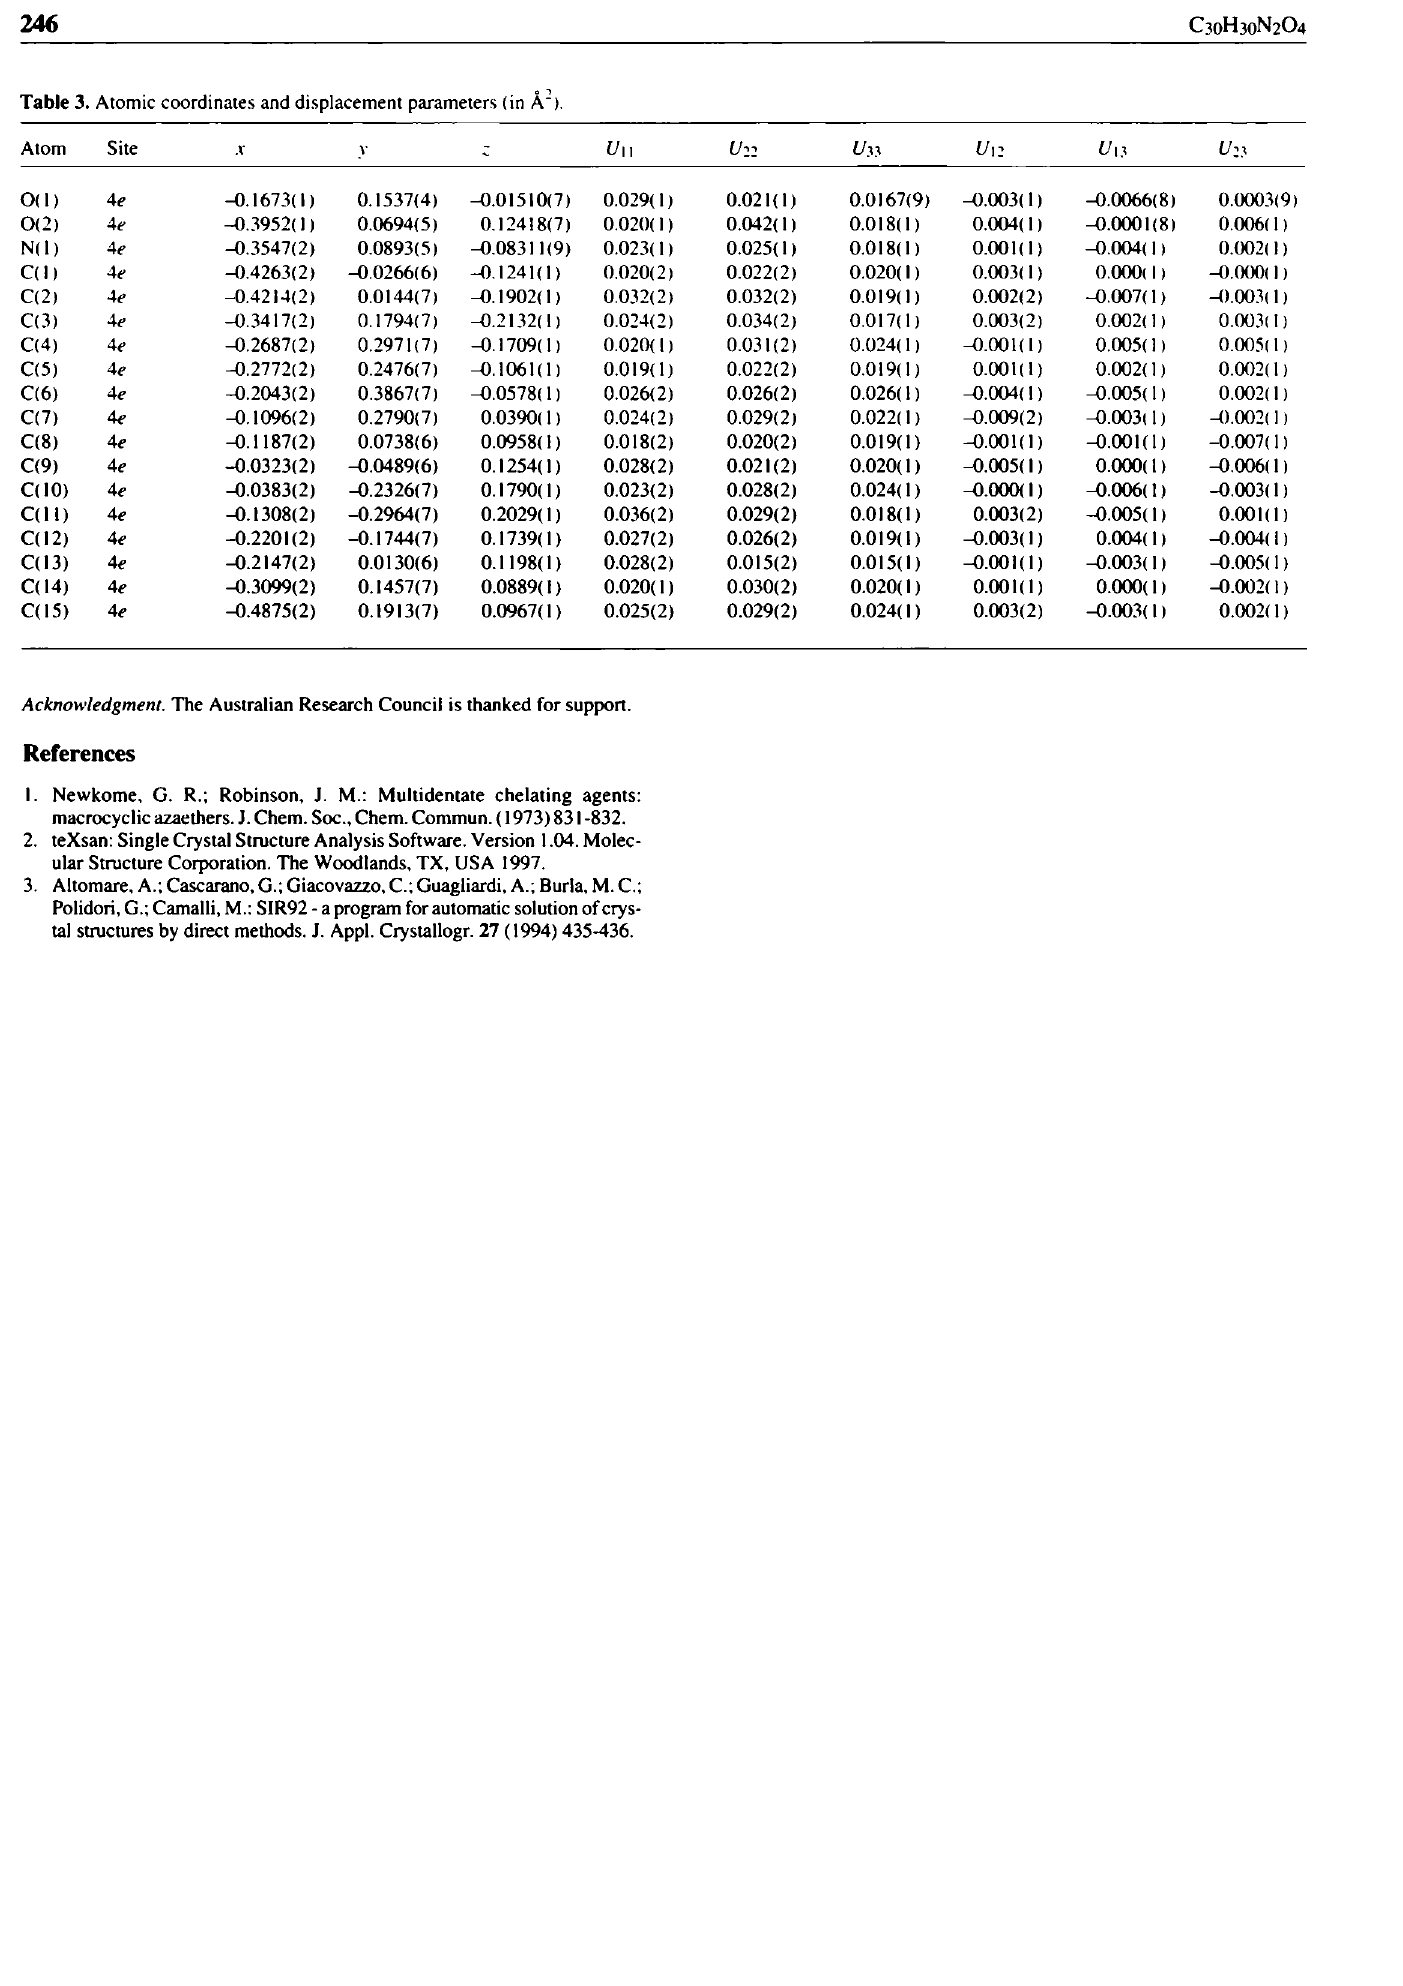
Table 3. Atomic coordinates and displacement parameters (in